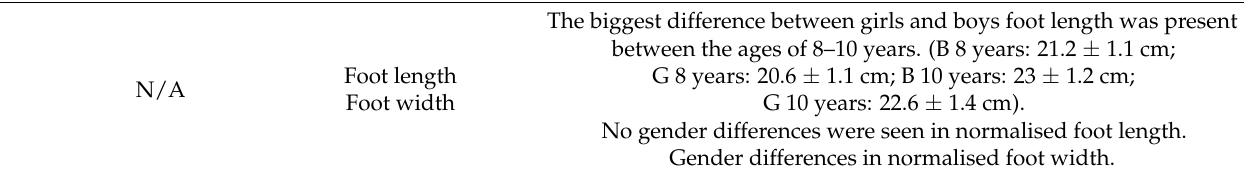
No gender differences were seen in normalised foot length. Gender differences in normalised foot